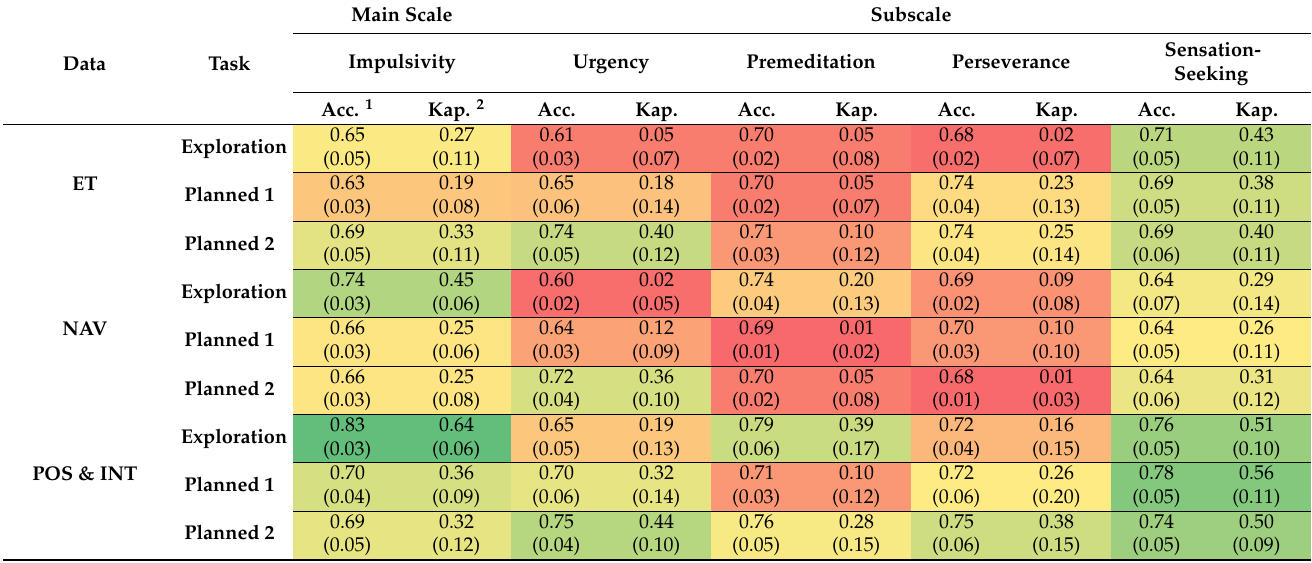
Table 3. Accuracy of prediction of each scale and subscale.